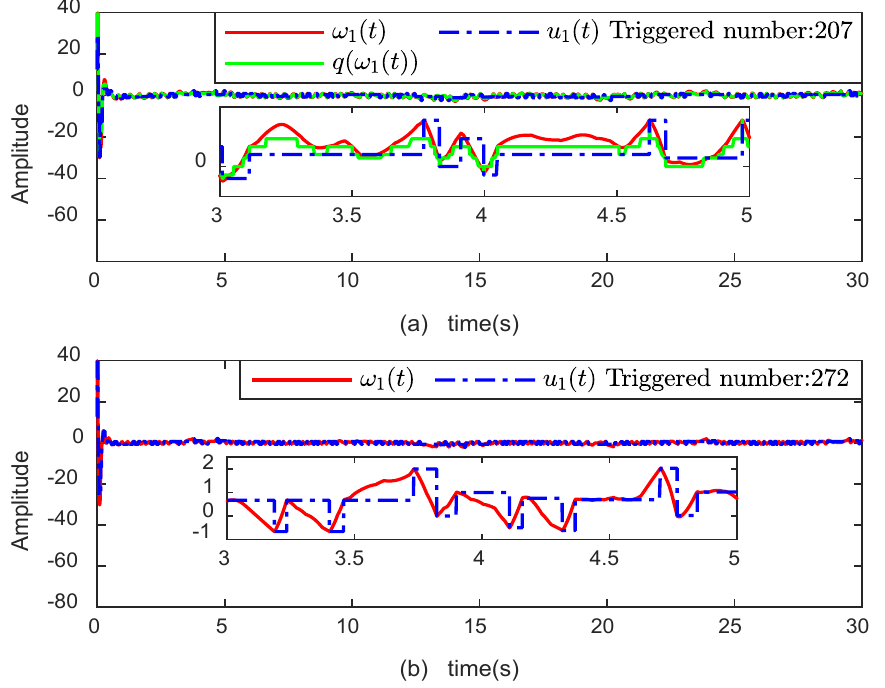
Figure 8. The trajectories of ω 1 , q ( ω 1 ) , and u 1 . ( a ) with quantized control. ( b ) without quantized